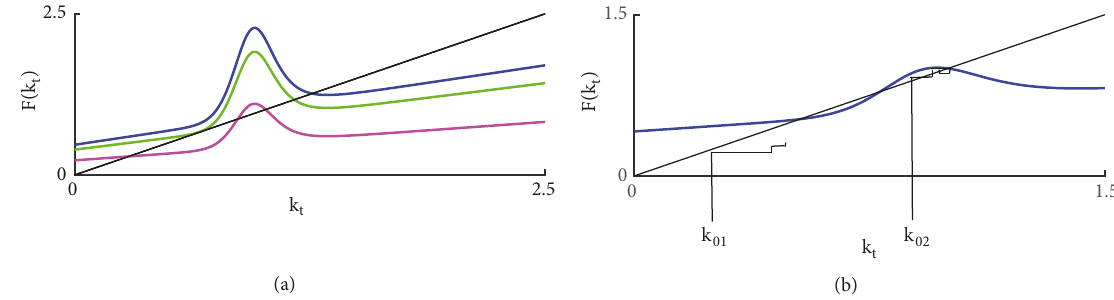
Figure 4: (a) Cases (a) in blue, (b) in green, and (c) in purple of Proposition 10. (b) Two coexisting